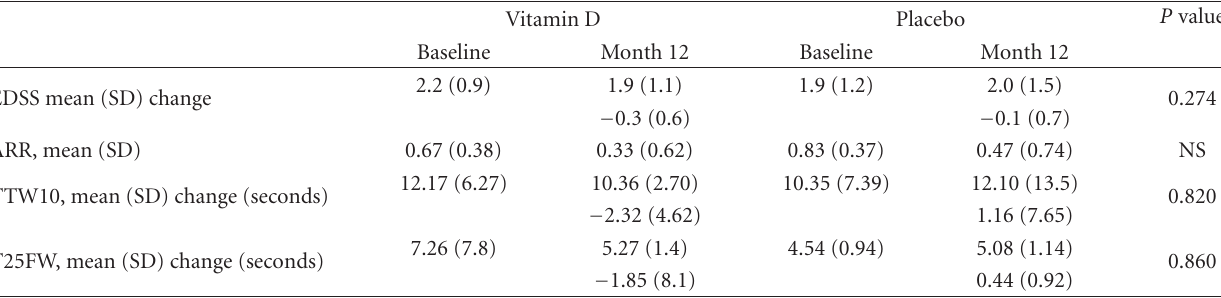
Table 3: Clinical outcomes in vitamin D- and placebo-treated active subgroup patients. Vitamin D Placebo Baseline Month